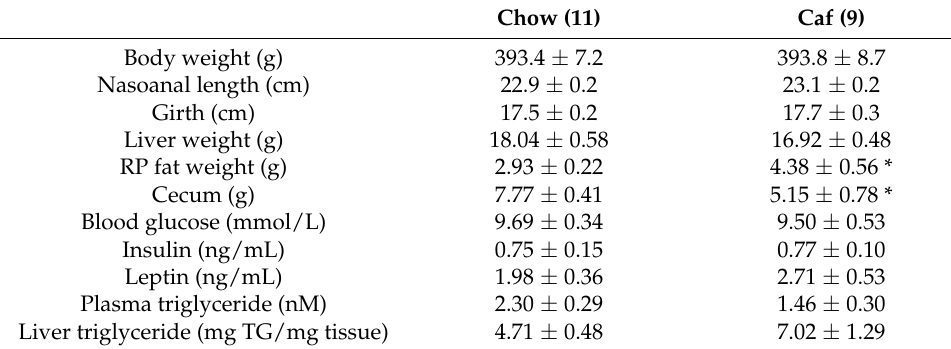
Table 2. Maternal endpoint measures at three weeks